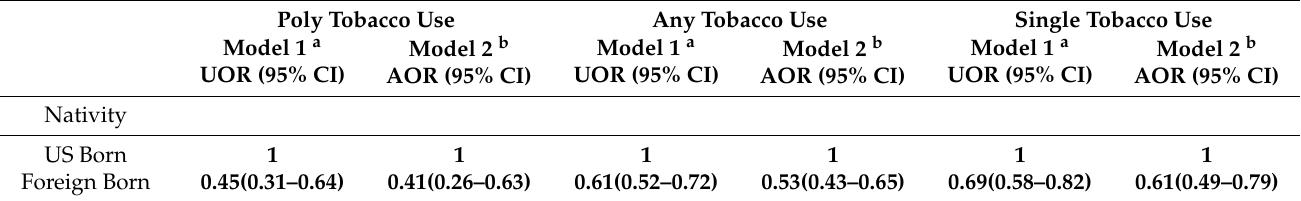
Table 3. Logistic regression results for tobacco product use by nativity status, NHIS 2015–2019, ( n = 9907). Poly Tobacco Use Any Tobacco Use Single Tobacco